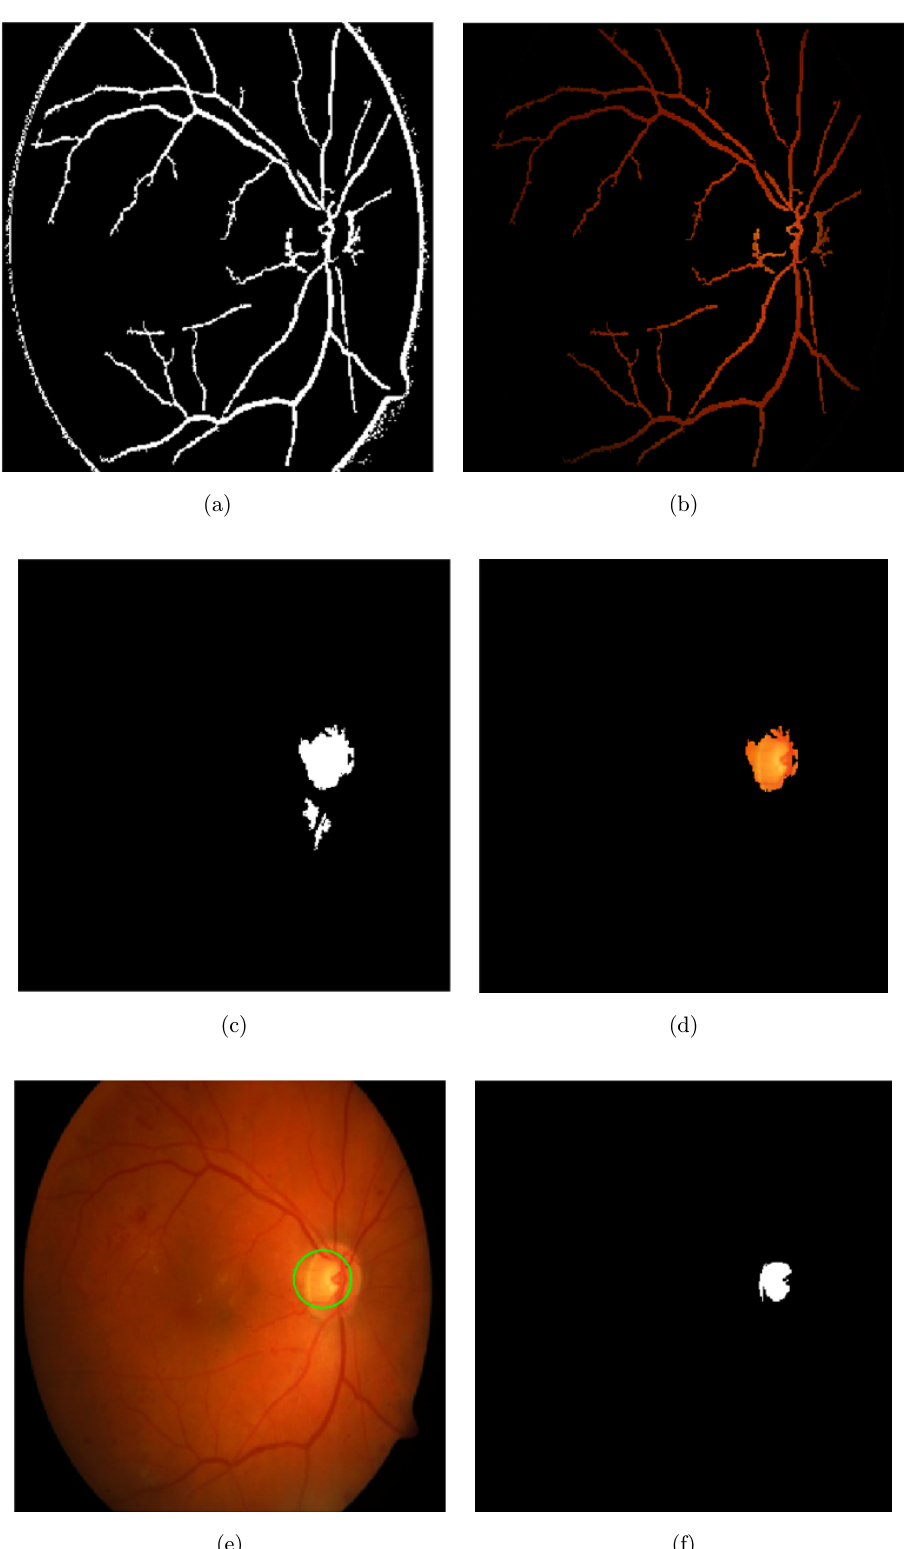
Fig. 4. (a) Blood vessel in binary representation. (b) Blood vessel extraction. (c) Optic disc binary representation. (d) Optic disc expected location. (e) Optic disc detection. (f) Cup region binary representation. (g) Cup region extraction and (h) Optic disc and cup region